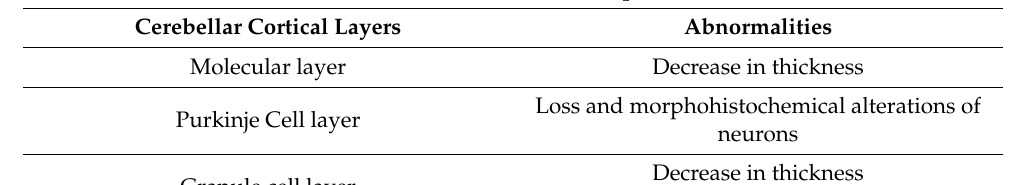
Table 1. Cerebellar neuropathological abnormalities in classical natural scrapie considered in this review (Section 3) and reflections on these studies on cerebellar neuropathological alterations in classical scrapie (Section 4).